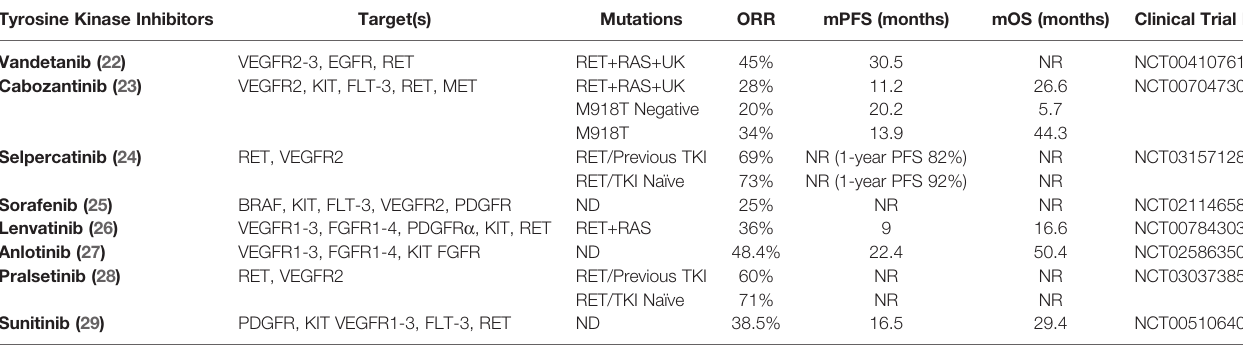
TABLE 1 | Summary of results of completed tyrosine kinase inhibitor trials. Tyrosine Kinase